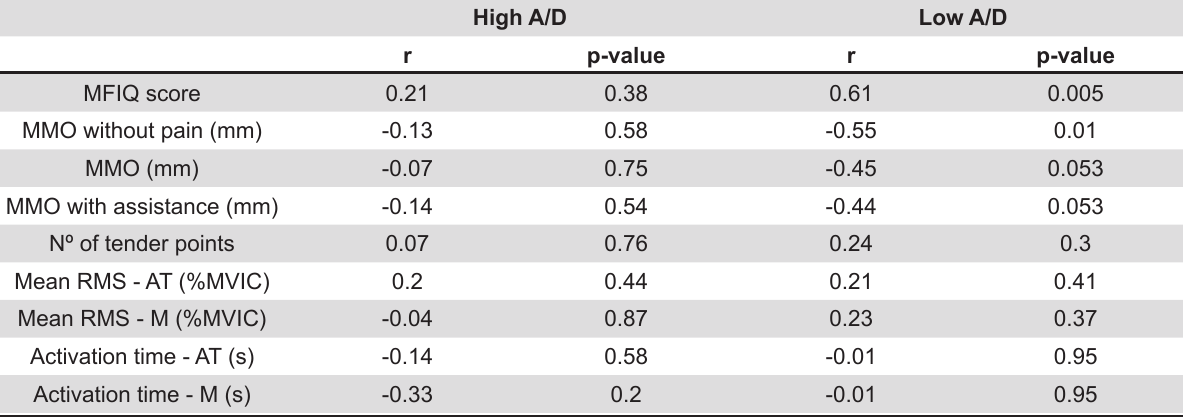
AT=anterior temporalis; M=masseter; MMO=maximum mouth opening; MFIQ=Mandibular Function Impairment Questionnaire; HADS=Hospital Anxiety and Depression Scale, A/D=Anxiety/Depression